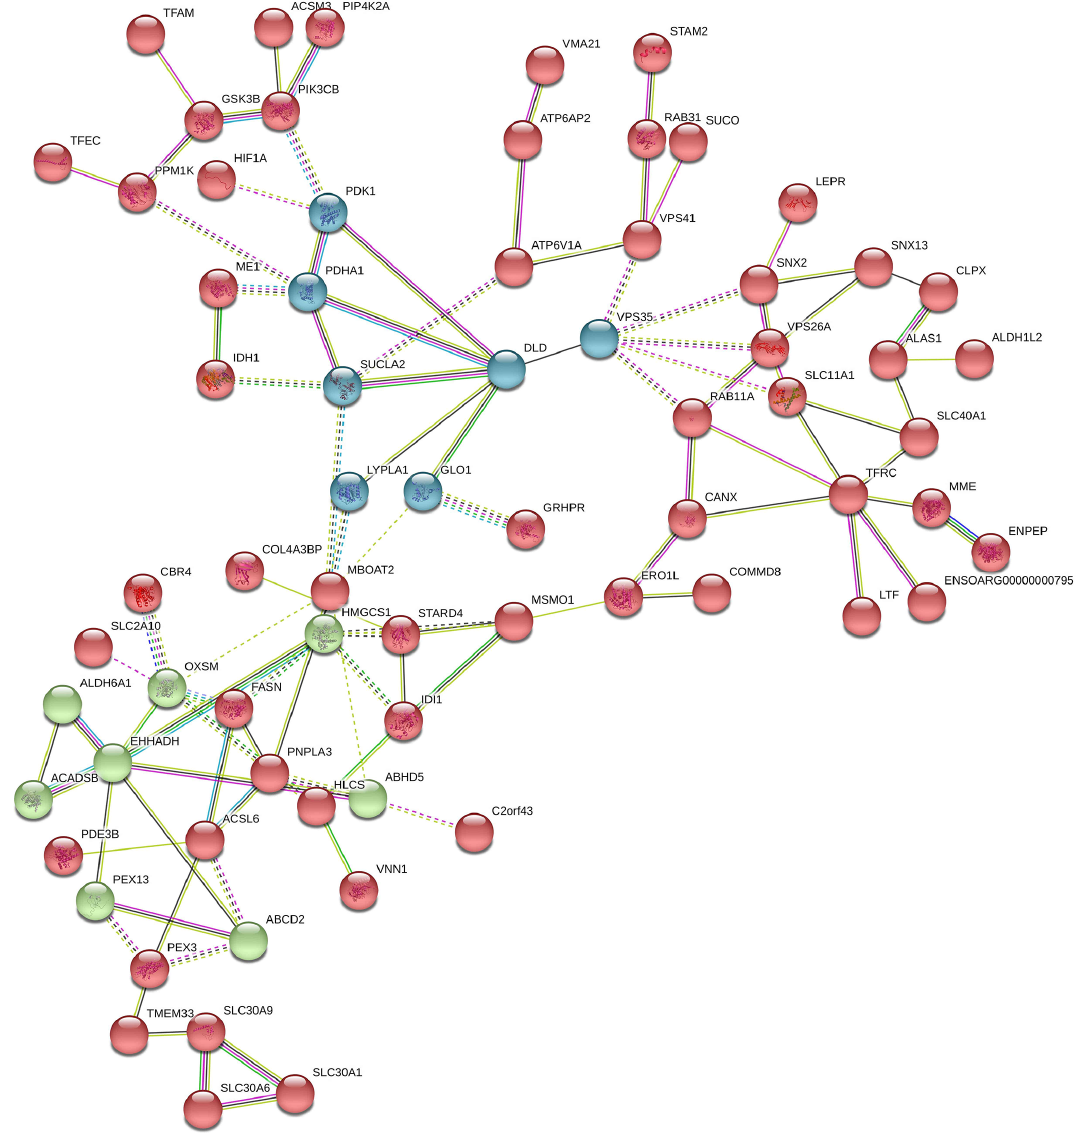
Figure 7. Protein–protein interaction (PPI) network and functional module analysis of down-regulated differentially expressed genes of adipose tissues of Zel (thin-tailed) compared to Ghezel (fat-tailed) sheep